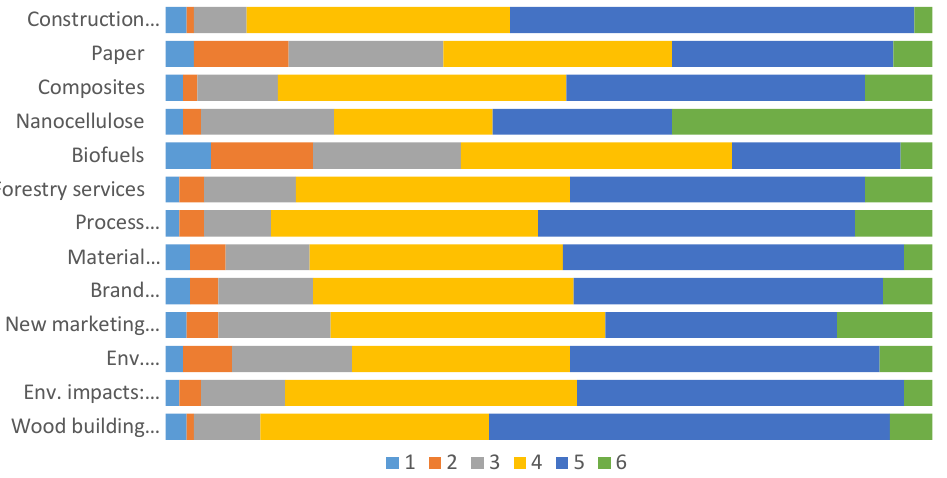
Figure 4. Respondent distribution to the statement: “For societal and sustainable development, I think the forest sector should focus their innovation efforts over the next 20 years on . . . ” (Scale from 1 = Strongly disagree, to 5 = Strongly agree, 6 = I don’t know).